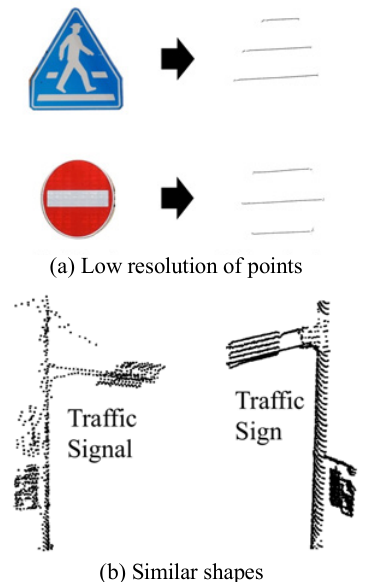
Figure 2. Failure cases of point-based object recognition.